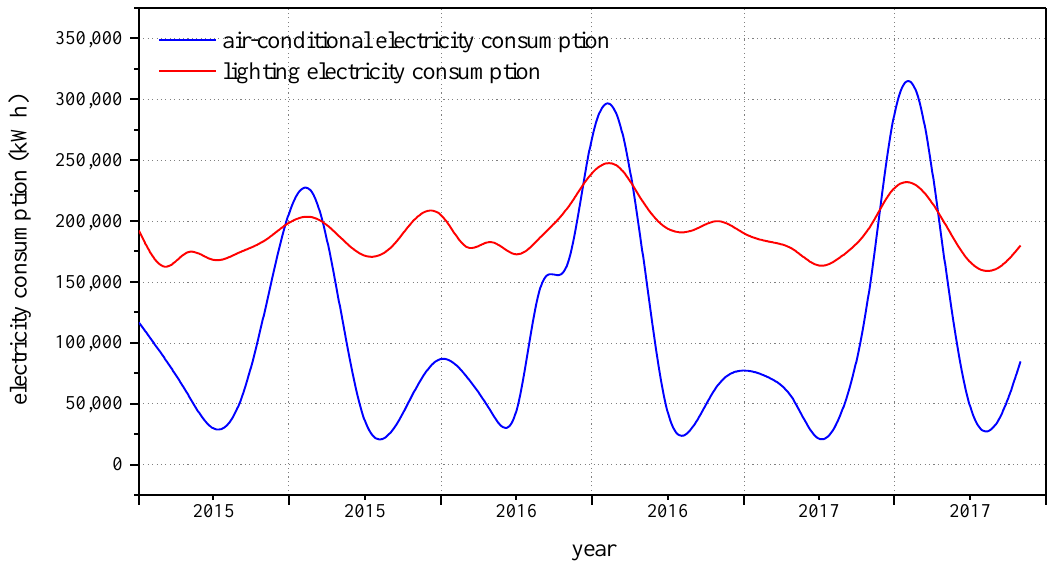
Figure 2. Monthly electricity consumption for air conditioning and lighting in a high-rise office from 2015 to 2017.